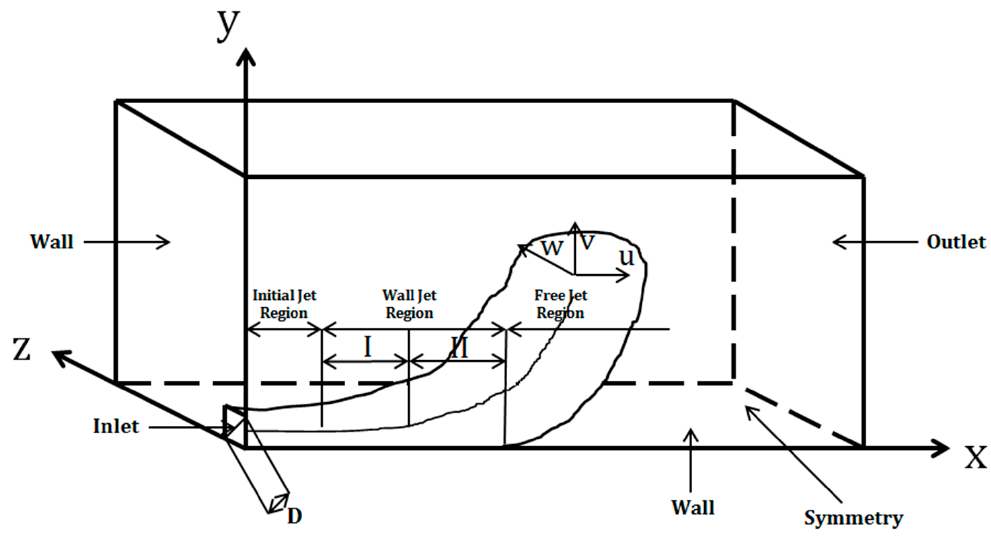
Figure 6. Schematic view of the model by [23].